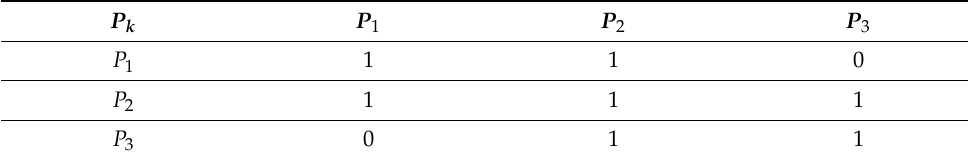
Table 3. Truth table based on the correlation